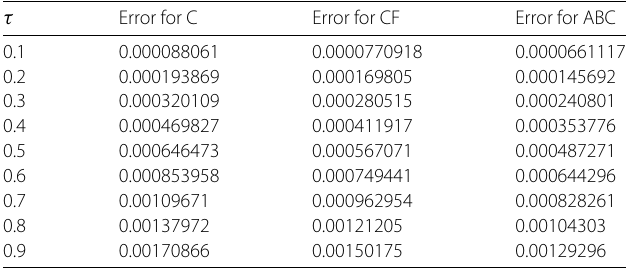
Table 3 AREs of x ( τ ) obtained by fourth-order OPIA solutions using different fractional operators at β = 0.9